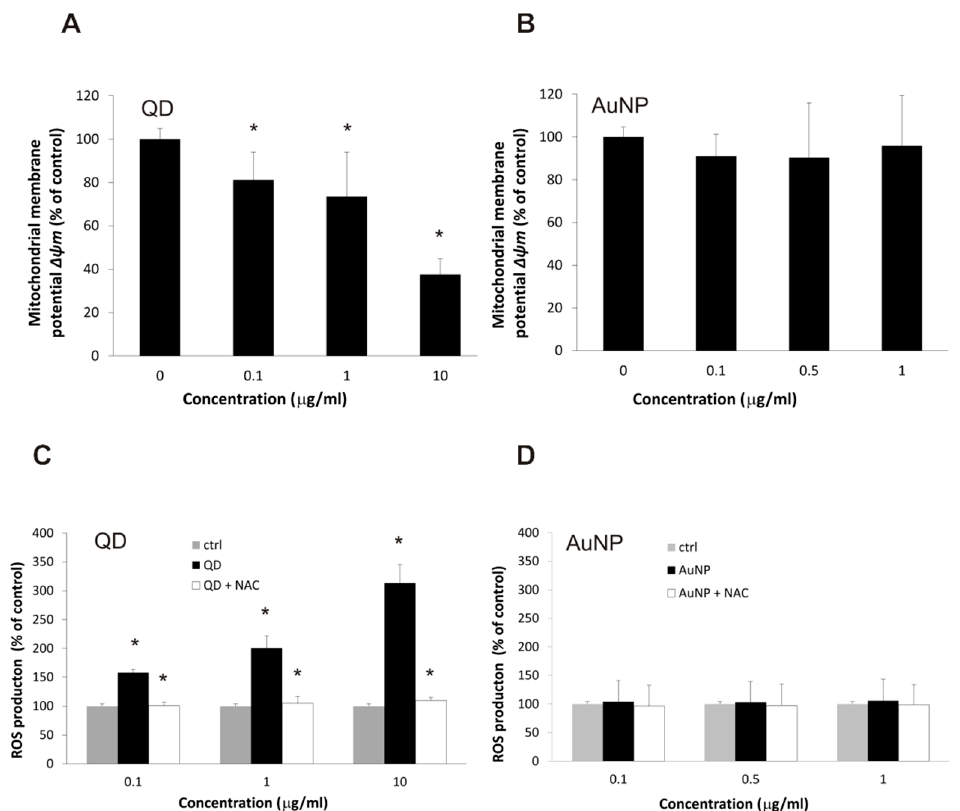
Figure 4. Cellular processes impacted by exposure to nanoparticles in brain microvascular endothelial cells. Mitochondrial potential (as a benchmark of cellular respiration) was measured by the JC-1 fluorescence method in the hCMEC/D3 cell line treated with QD (panel ( A )) and AuNP (panel ( B )) nanoparticles, calculated as the ratio of dimer to monomer fluorescence and presented as the percentage of value for control (non-exposed) cells. Data shown as average ± S.D. ( n = 5), asterisks indicate differences from control (untreated cells) which were statistically significant at p < 0.05. Rate of reactive oxygen species production (as benchmark of redox homeostasis) was measured by the dichlorofluorescein fluorescence method in the hCMEC/D3 cell line treated with QD (panel ( C )) and AuNP (panel ( D )) nanoparticles with or without N-acetylcysteine (NAC) as a ROS scavenger, calculated as the rate of fluorescence increase and presented as the percentage of value for control (non-exposed) cells. Data shown as average ± S.D. ( n = 8), asterisks indicate differences from control (untreated cells) which were statistically significant at p < 0.05.